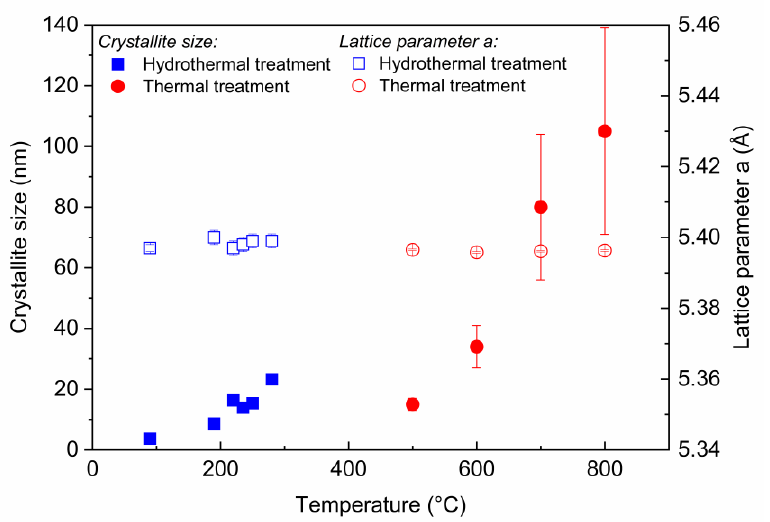
Figure 5. Crystallite size and lattice parameter a as a function of temperature, determined for the hydrothermally converted PuO 2 samples (blue) and for the PuO 2 samples (red) obtained by thermal decomposition of Pu(IV) oxalate (J.-F. Vigier, unpublished data). The data points at T = 95 °C are from Walter et al. (PuO 2 obtained by hydrothermal conversion of Pu(IV) oxalate). Lower error bar is included in the symbols.